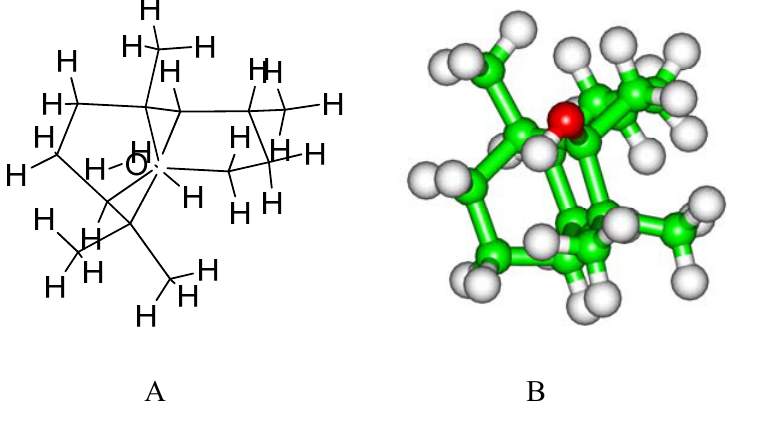
Figure 1. Chemical ( A ) and stereo ( B ) structures of patchouli